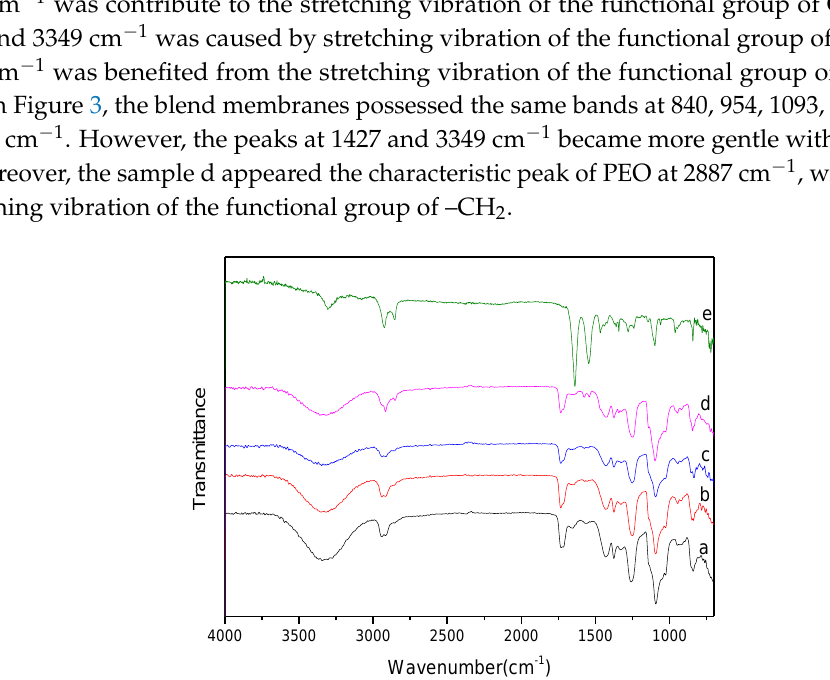
Figure 3. FT-IR of PVA/PEO membranes. ( a ) 8 wt % PVA; ( b ) 8 wt % PVA/3 wt % PEO (90/10); ( c ) 8 wt % PVA/3 wt % PEO (80/20); ( d ) 8 wt % PVA/3 wt % PEO (70/30); ( e ) 3 wt % PEO. FT-IR: Fourier Transform-Infrared; PVA: Polyvinyl alcohol; PEO: Polyethylene